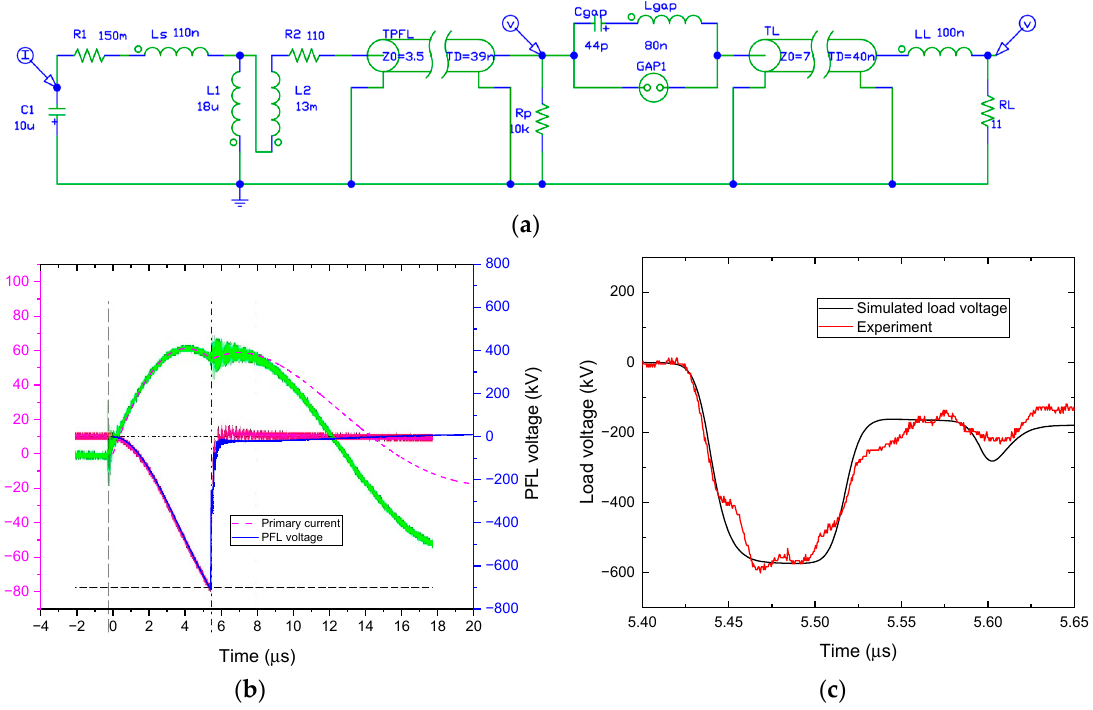
Figure 12. Equivalent circuit and simulation results: ( a ) Equivalent circuit; ( b ) Comparison of the primary current and PFL voltage with experiment (green and red curves); ( c ) Comparison of load voltage with experiment (red curve).